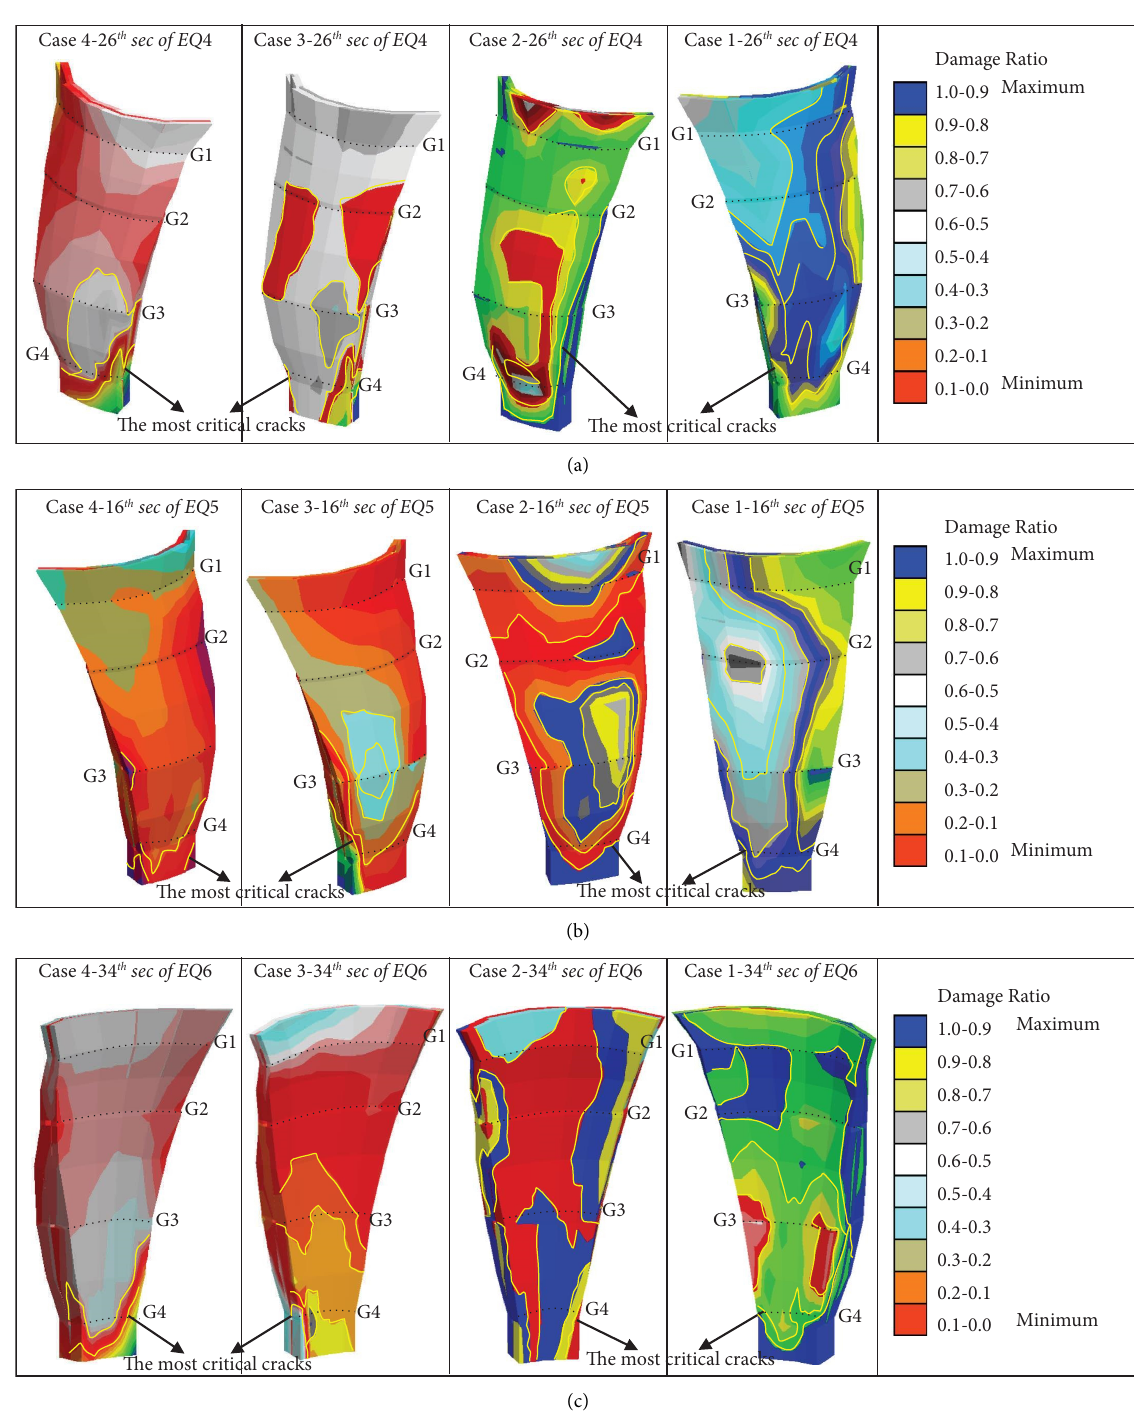
Figure 13: Earthquake crack performance of Ermenek arch dam for (a) EQ4 earthquake, (b) EQ5 earthquake, and (c) EQ6